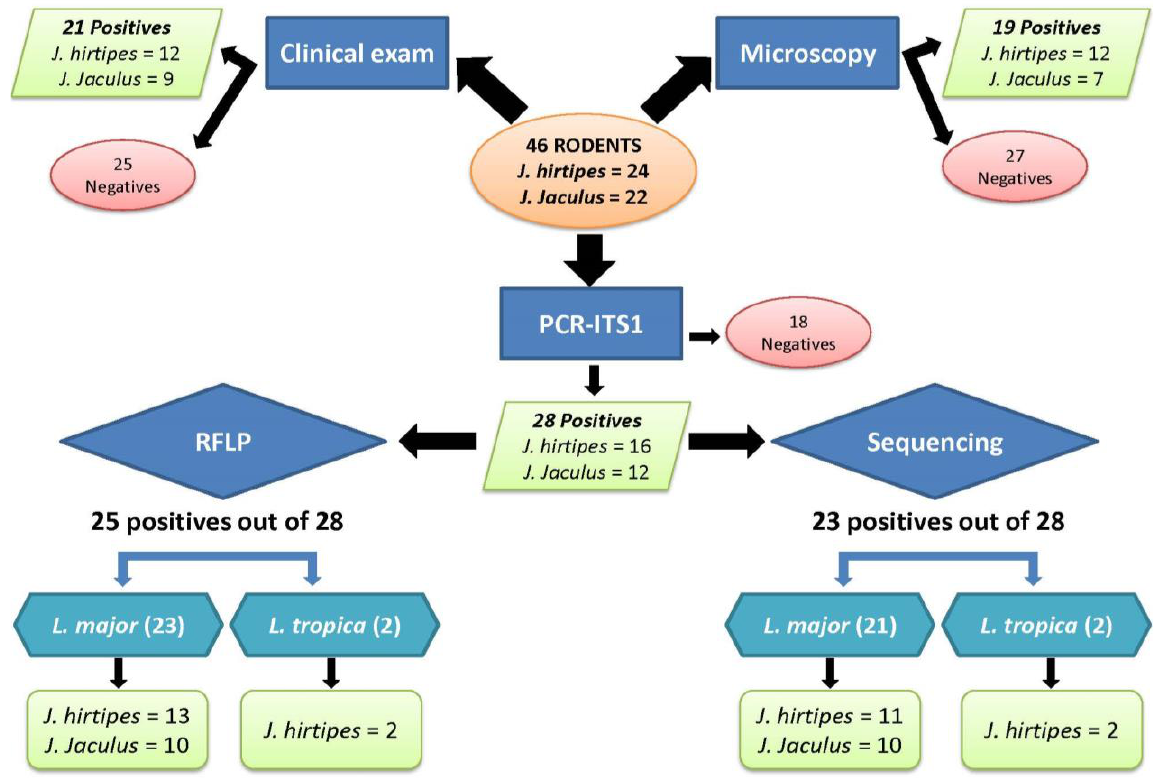
Figure 1. Flowchart summarizing the process and the results of Leishmania diagnosis and identifica- tion among Jaculus species. PCR-ITS1: PCR targeting ribosomal internal transcribed spacer 1; RFLP: Restriction fragment length polymorphism.